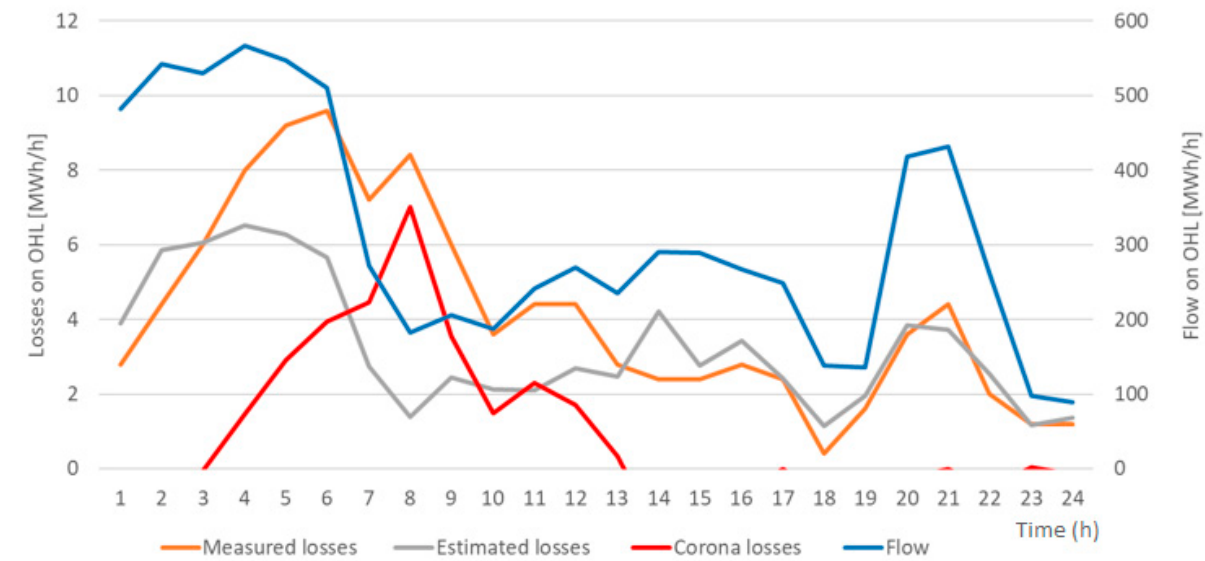
Figure 21. Measured losses and classification of losses for the 400 kV OHL on the chosen day, 20 May 2020 .